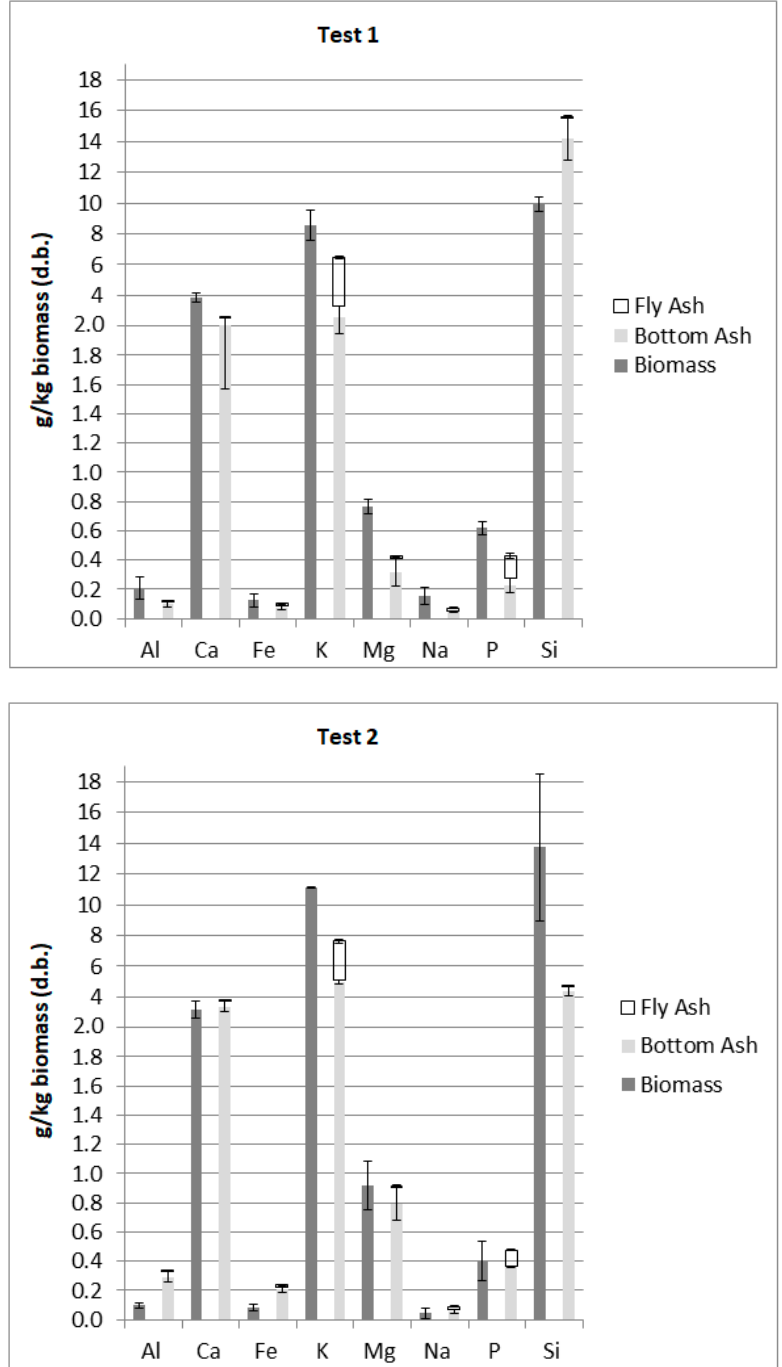
Figure 4. Main elements content of the biomass, and fly and bottom (slag) ashes per kg of fed biomass (dry basis).